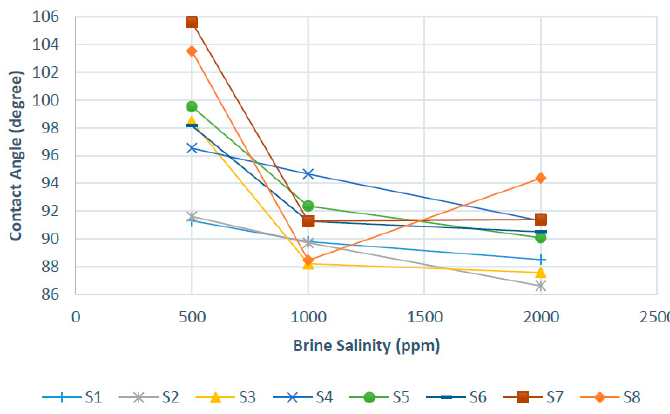
Figure 9. Contact angle value of each sample for brines B1, B2 and B3.